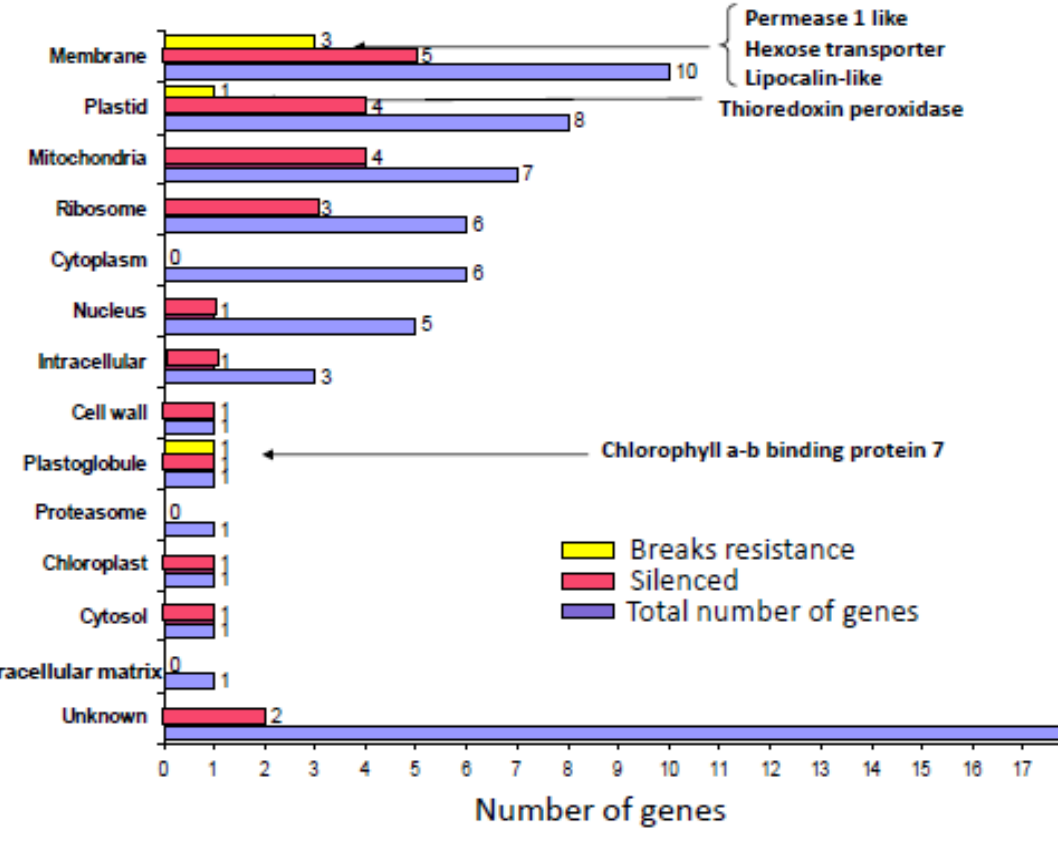
Figure 3. Genes preferentially expressed in R plants (Gene ontology, cellular component). The number of genes silenced so-far and the genes which silencing leads to collapse of resistance are